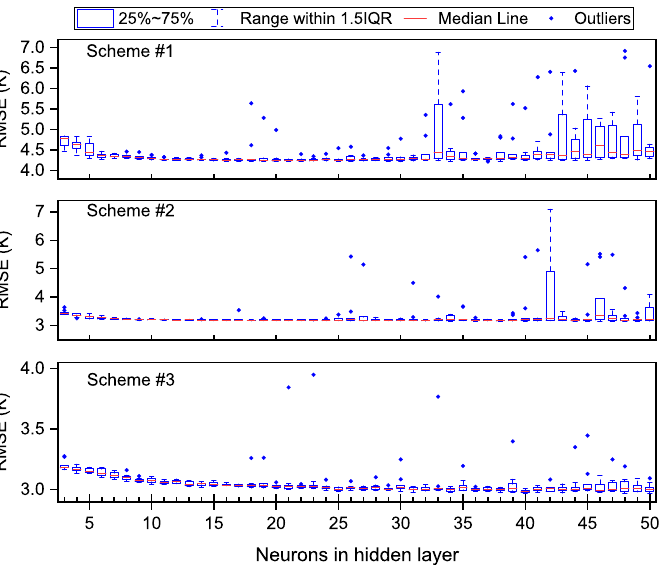
Figure 5. RMSE of each training mission validated with radiosonde data from 2014 to